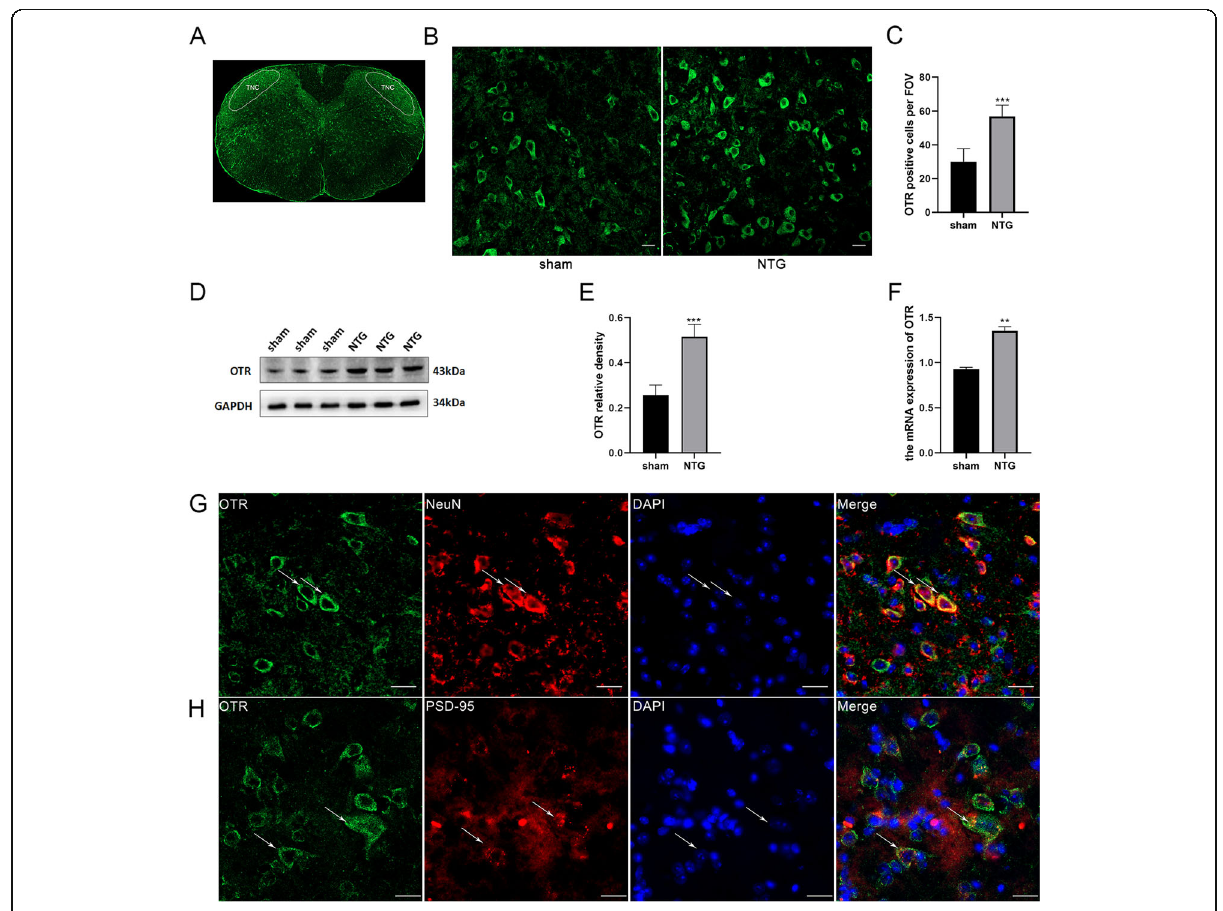
Fig. 2 The increase of OTR in CM mouse and the distribution of OTR in the TNC. A The white full line frame indicates the TNC area stained for OTR. B Representative images of OTR immunoreactivity in the sham and NTG groups. C The average number of OTR-positive cells in the NTG group was significantly increased compared to that in the sham group (scale bar: 20 μ m). D and E WB analysis showed that OTR protein expression in the NTG group was significantly increased compared with that in the sham group. F The mRNA expression of OTR in the NTG group was statistically higher than that in the sham group. G Double immunofluorescence labeling of OTR (green) and NeuN (red). In the TNC, most OTR was distributed in neurons (scale bar: 50 μ m). H Double immunofluorescence labeling of OTR (green) and PSD-95 (red). Some OTR was colocalized with the postsynaptic membrane in the TNC (scale bar: 50 μ m). Two-tailed Student ’ s t-test, n = 4/group for immunofluorescence analysis, n = 6/group for WB analysis; ** p < 0.01, *** p < 0.001 vs. the sham